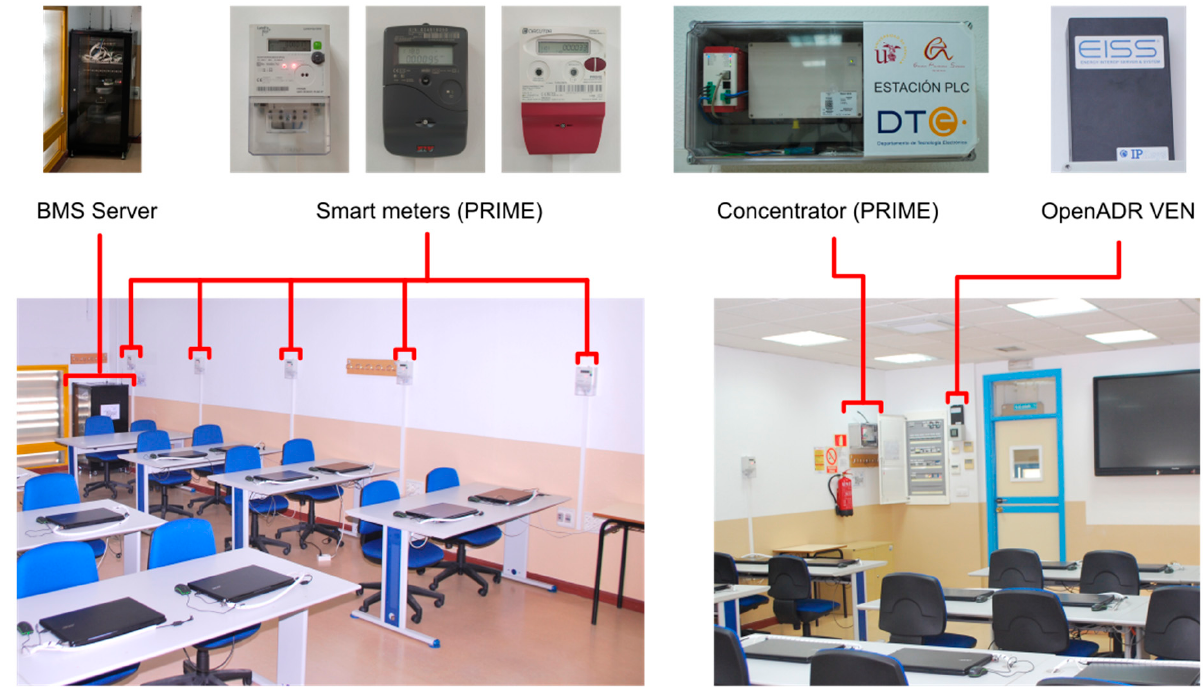
Figure 7. DERBis control and measurement devices.